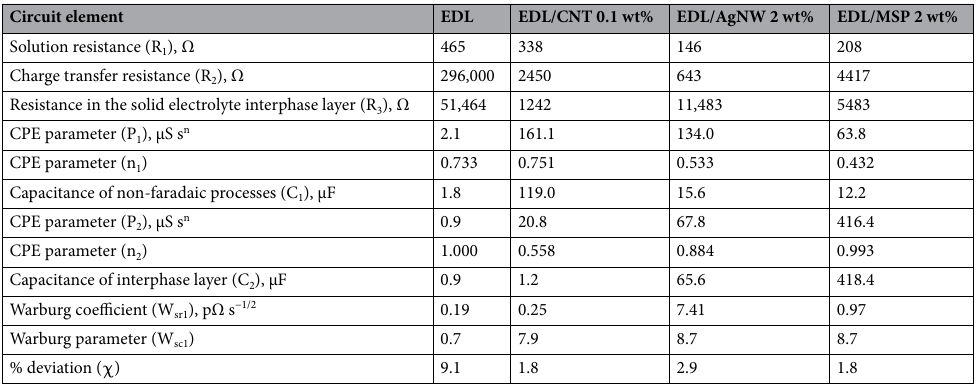
Table 1. Representative set of electrical parameters derived from an equivalent circuit modelling of EIS data for pristine EDL, EDL/CNT 0.1 wt%, EDL/AgNW 2 wt% and EDL/MSP 2 wt%.